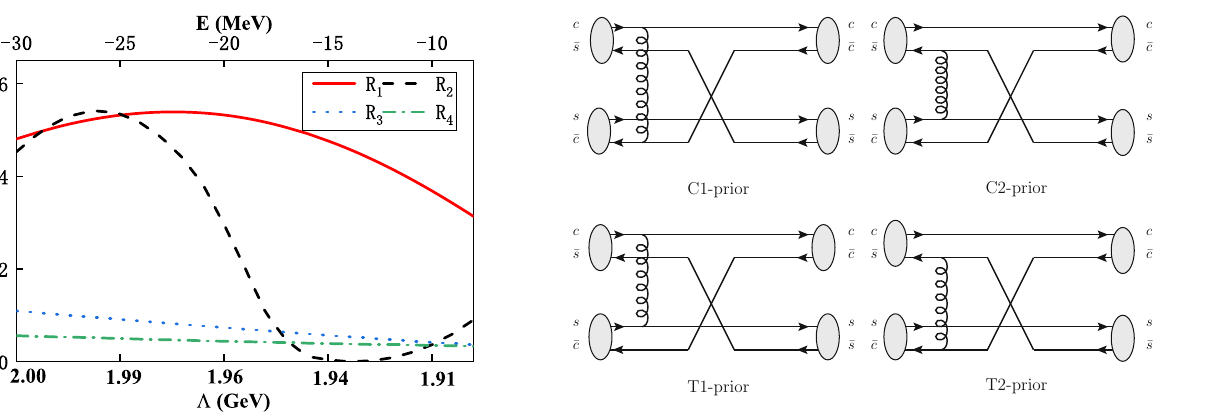
Fig. 4 Quark-interchange diagrams for the scattering process A ( c ¯ s ) + Fig. 3 The dependence of the decay ratios on cutoff (cid:10) and bind- B ( ¯ cs ) → C ( c ¯ c ) + D ( s ¯ s ) in the molecular picture [56]. The curve line ing energy E for the D ∗ s ¯ D s 1 the state with J PC = 1 −+ . Here, denotes the (anti-)quark-(anti-)quark /(cid:4) = (cid:4) η /(cid:4) = we defined R 1 = (cid:4) η J /ψφ , R 2 J /ψφ , R 3 c ( 2 S )η c ( 2 S )η (cid:4) (cid:4) χ /(cid:4) = (cid:4) χ /(cid:4) J /ψφ , and R 4 J /ψφ c 1 ( 1 P )η c 1 ( 1 P )η (cid:4)